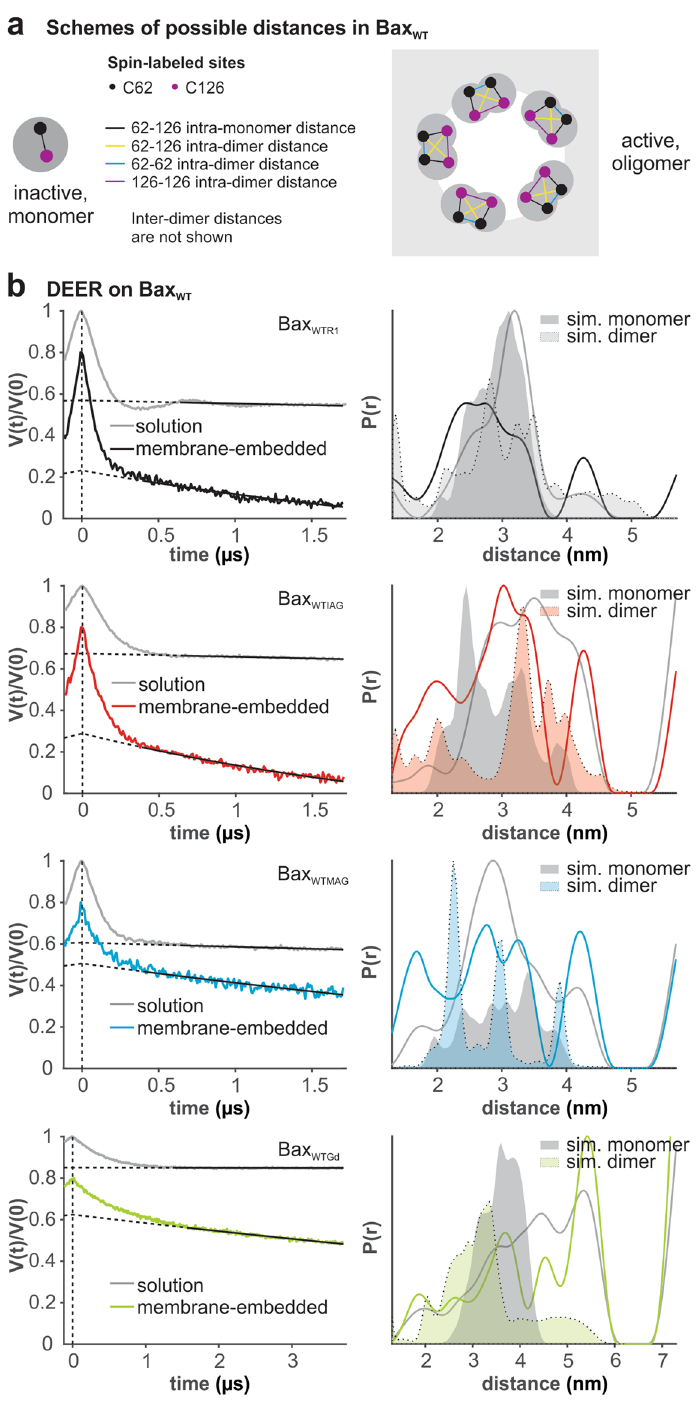
Figure 2. DEER data of spin-labeled Bax WT variants in solution and in membranes. ( a ) Schemes of possible interspin distances. ( b ) Primary data with background functions (left) and distance distributions (right) in the monomeric (solution) and oligomeric (membrane-embedded) conformations obtained by Tikhonov regularization with DeerAnalysis2018 54 . Shaded areas present simulations of intra-monomer and intra-dimer distances based on the structures in 12,18,20 . Data evaluation and validation is provided in Supp. Figs